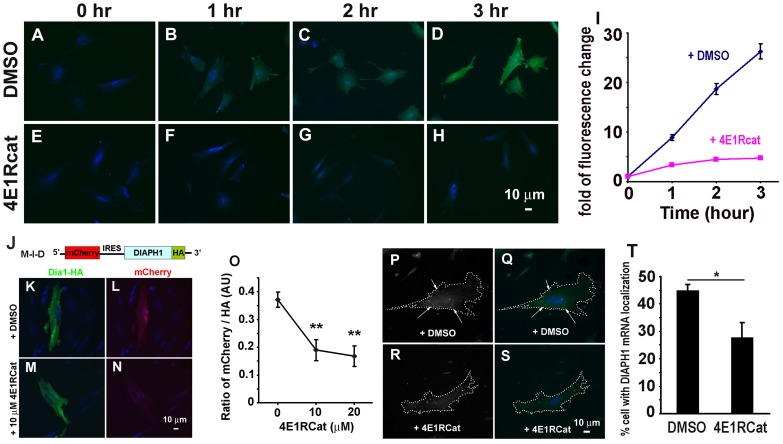
5′-cap-mediated translation is required for perinuclear DIAPH1 mRNA localization.
A–H, 4E1RCat inhibits the majority of new protein synthesis (assayed with Click-iT kit, see Materials and Methods for details). I. Quantitative results of 4E1RCat inhibition of new protein synthesis. ∼120 cells were analyzed for each time point per condition from three independent experiments. J. Illustration of bicistronic expression plasmid M-I-D (for mCherry-IRES-DIAPH1). K–N. 4E1RCat inhibits cap-mediated but not IRES-mediated translation. Representative images show transfected cells treated with DMSO (K,L) or 10 µM of 4E1RCat (M,N). CEF were first transfected with the bicistronic plasmid for 2 hr and then incubated with DMSO or 10 µM 4E1RCat for 11 hr. The cells were fixed and processed for immunofluorescence staining for the HA tag. Fluorescence images were acquired and quantified. O. Quantitative result of mCherry/HA ratio in single cells. (n = 12–24). ** p<0.01. P–S. Inhibition of cap-mediated translation delocalizes DIAPH1 mRNA. CEF were incubated with DMSO or 10 µM of 4E1RCat in growth medium for 3 hr and then fixed for mRNA detection. P–S, representative cells treated with DMSO or 4E1RCat. Images in left column are gray scale for better display of DIAPH1 mRNA signal. Dotted lines indicate cell border. Arrows indicate localizing DIAPH1 mRNA. In right column, green: DIAPH1 mRNA, blue: nucleus. Note that cells treated with 4E1RCat show diffused DIAPH1 mRNA. Scale bar: 10 µm. T. Quantitative result of endogenous DIAPH1 mRNA localization in treated CEF. 300–500 cells were scored from three independent experiments for each condition. * p<0.05.